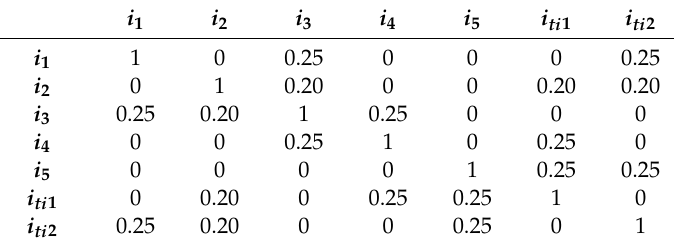
Table 5. Example of item similarity information